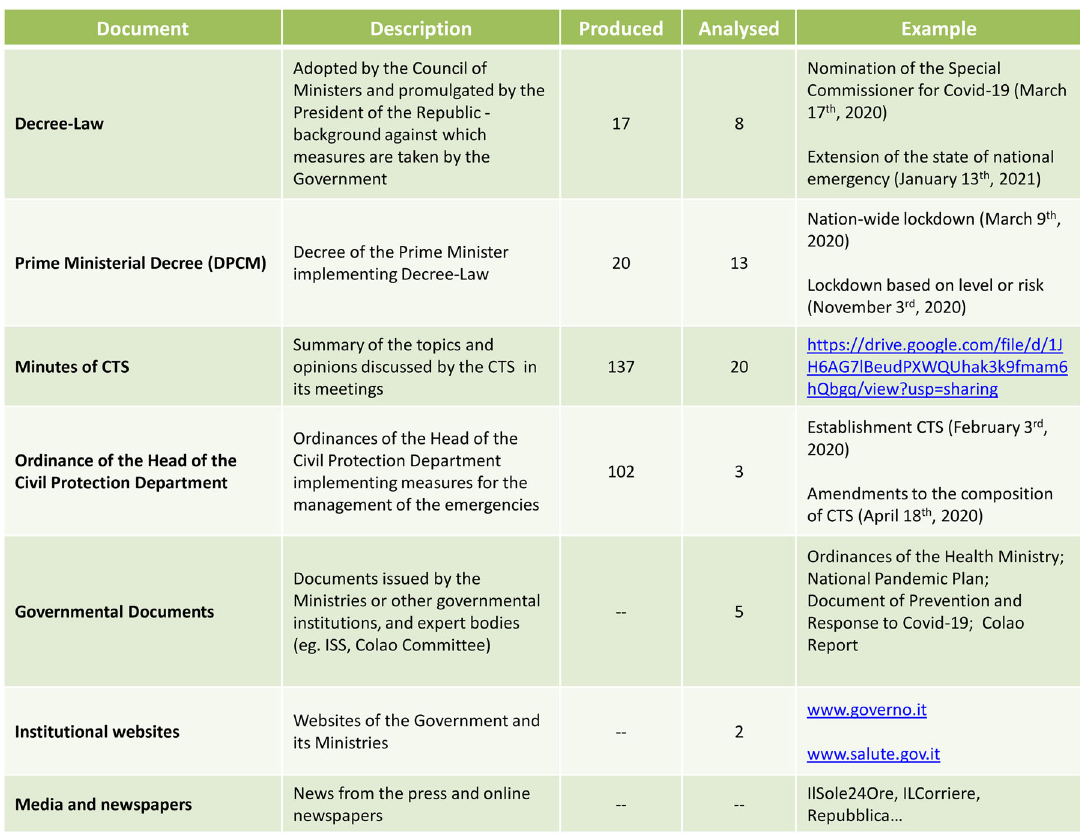
Fig. 2 Type and number of secondary documents collected and analyzed for this case study. Figure by